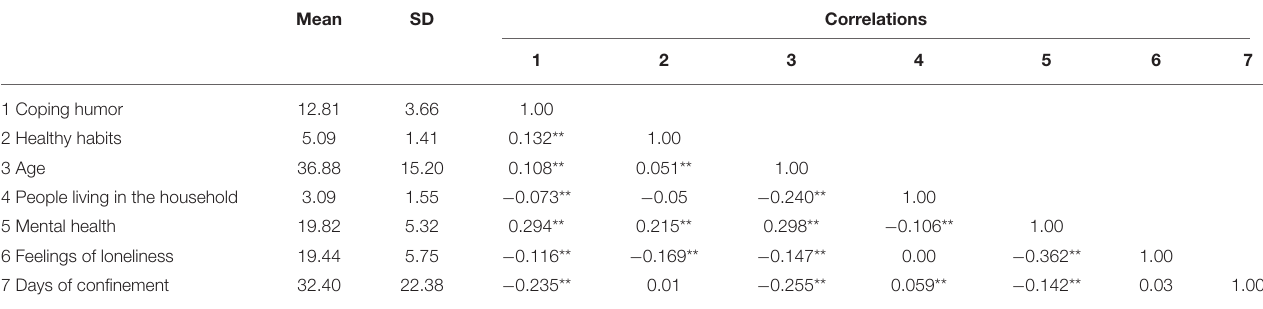
TABLE 2 | Descriptive and correlational analysis of the model’s numerical variables.